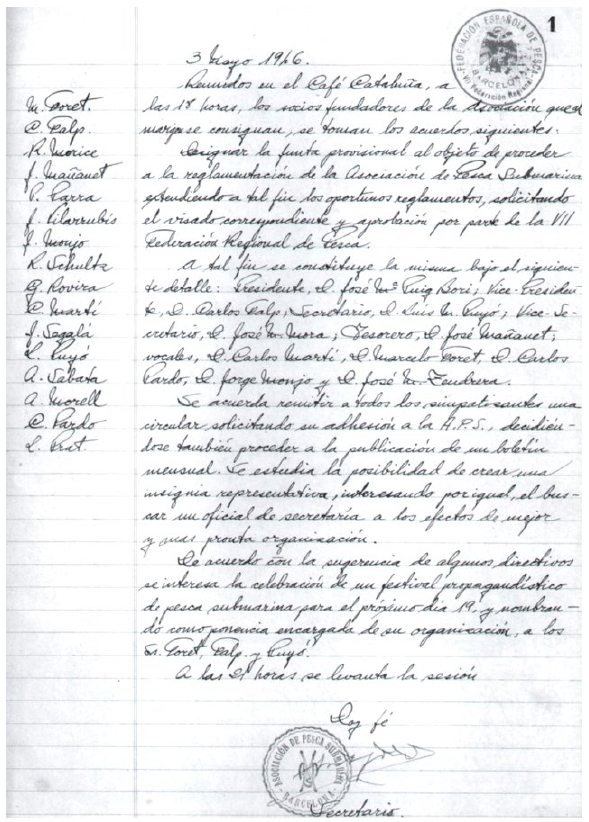
Fig. 1 – Deed of Constitution of the Spearfishing Association of Barcelona (3 May